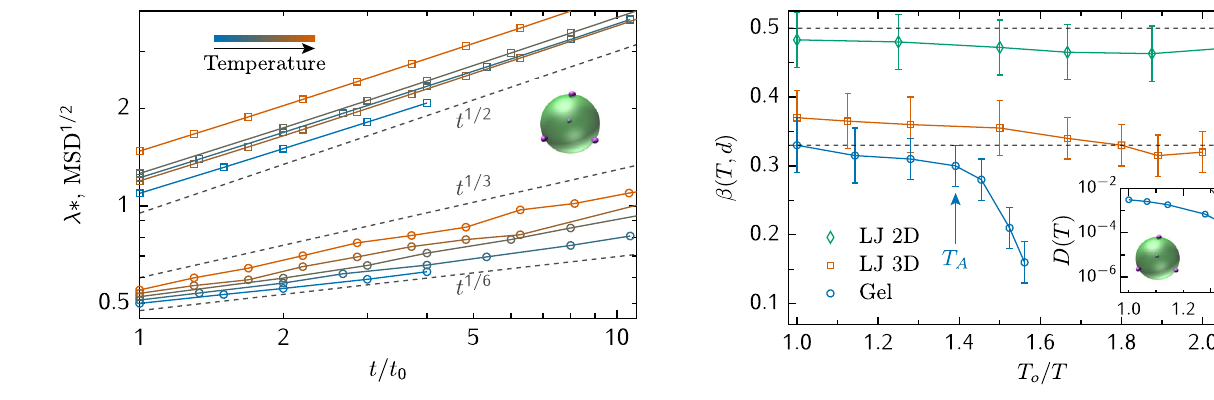
FIG. 4. Compendium of β exponents. β ð T ; d Þ in the time regime t ≥ t 0 as a function of the temperature for the three (cid:3) systems investigated. Here, T o stands for the onset temperature for the two Lennard-Jones systems and for the percolation for the temperature for the tetrahedral gelling system (see Sec. VI). (cid:3) The explored T range goes from the liquid state to the deep supercooled regime. Horizontal dashed lines serve as a refer- ence for 1 = 2 and 1 = 3 . A vertical arrow signals the temperature T A at which the tetrahedral gelling system enters into the Arrhenius regime [40]. Inset: diffusion coefficient D ð T Þ (ob- tained from the measured MSD) as a function of the temper- ature for the tetrahedral gelling system (dashed line serves as a reference for the exponential low- T Arrhenius behavior which starts at T A )